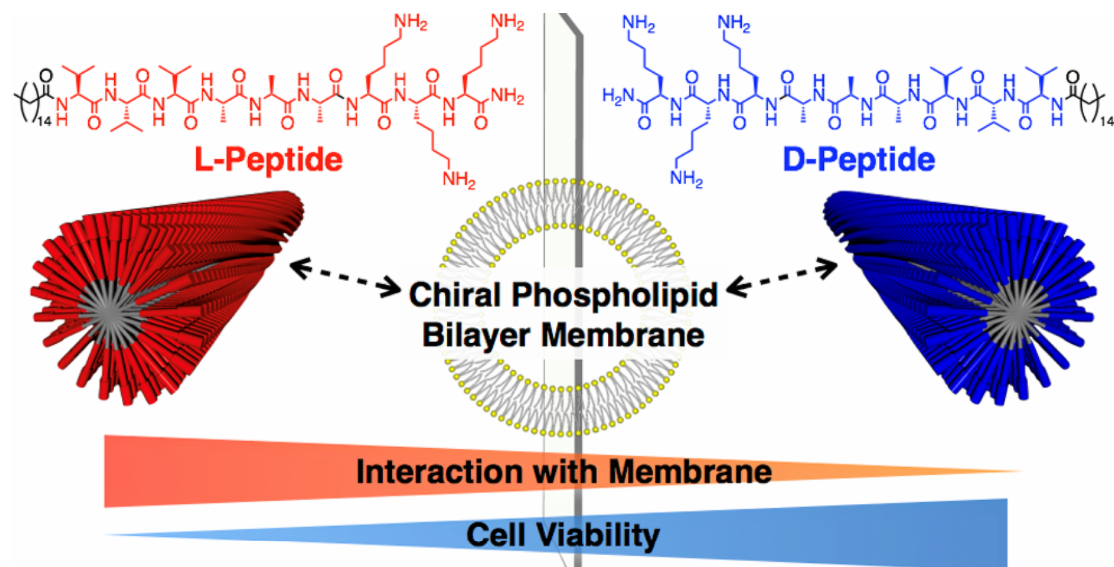
Figure 3. Chiral recognition of lipid bilayer membranes by supramolecular assemblies of peptide amphiphiles. Reprinted with permission from ref. [71]. Copyright (2019) American Chemical Society.